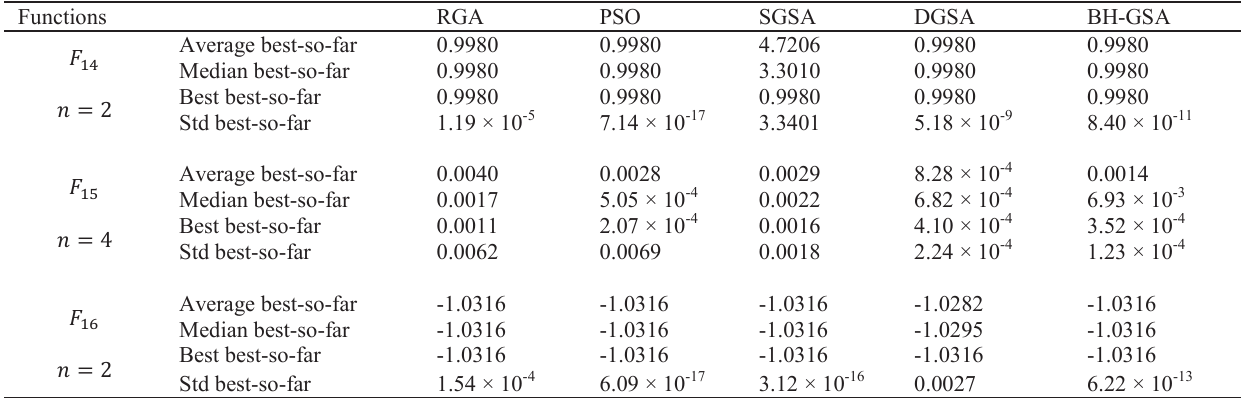
Table 6. Minimization result of benchmark functions in Table 3 with